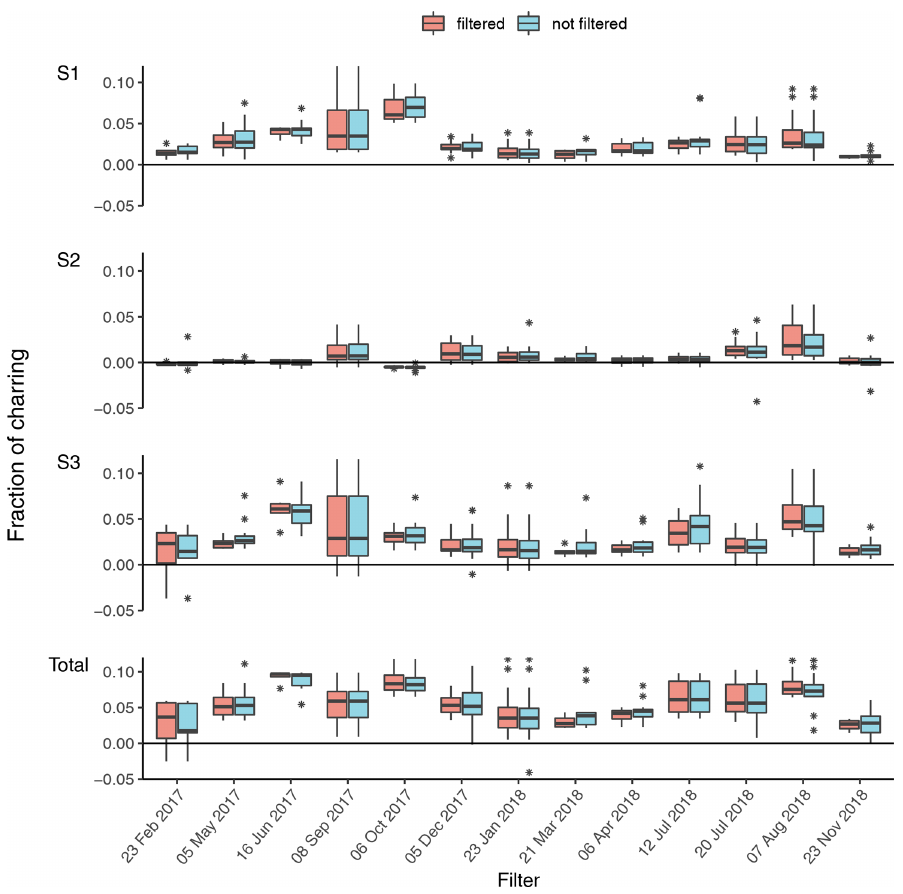
Figure 4. Fraction of charring observed for each filter at the individual steps (S1, S2, S3) and the total (sum of S1, S2, S3) with the sampling start date. Filtered (WINSOC removal containing outliers in EC yield, fraction of charring S1, S2, or S3 removed) and unfiltered fractions of charring for each filter are shown. The fraction of charring describes the amount of artificially produced EC by charring OC related to the amount of EC on the filter based on the laser transmission signal; i.e. a total charring of 0.05 means a 5% contamination of the total EC